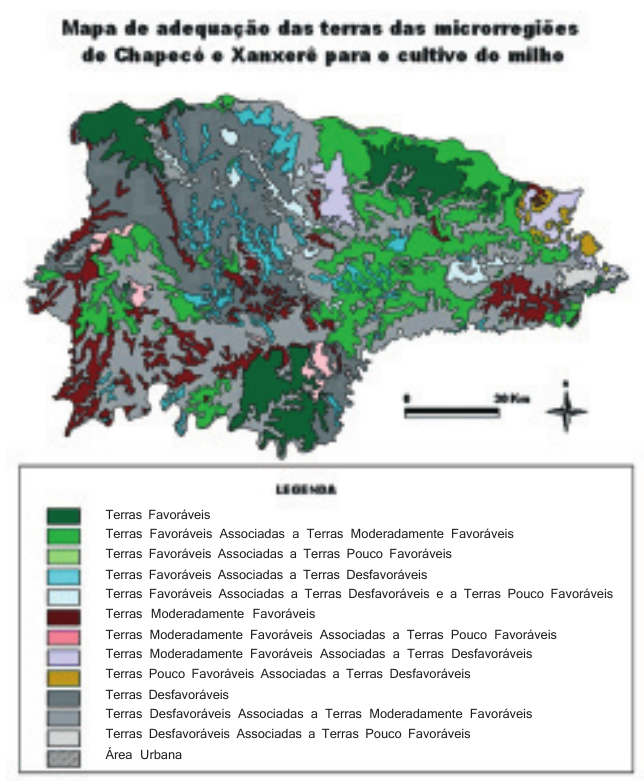
Figura 8. Classes de adequação das terras para o cultivo do milho.